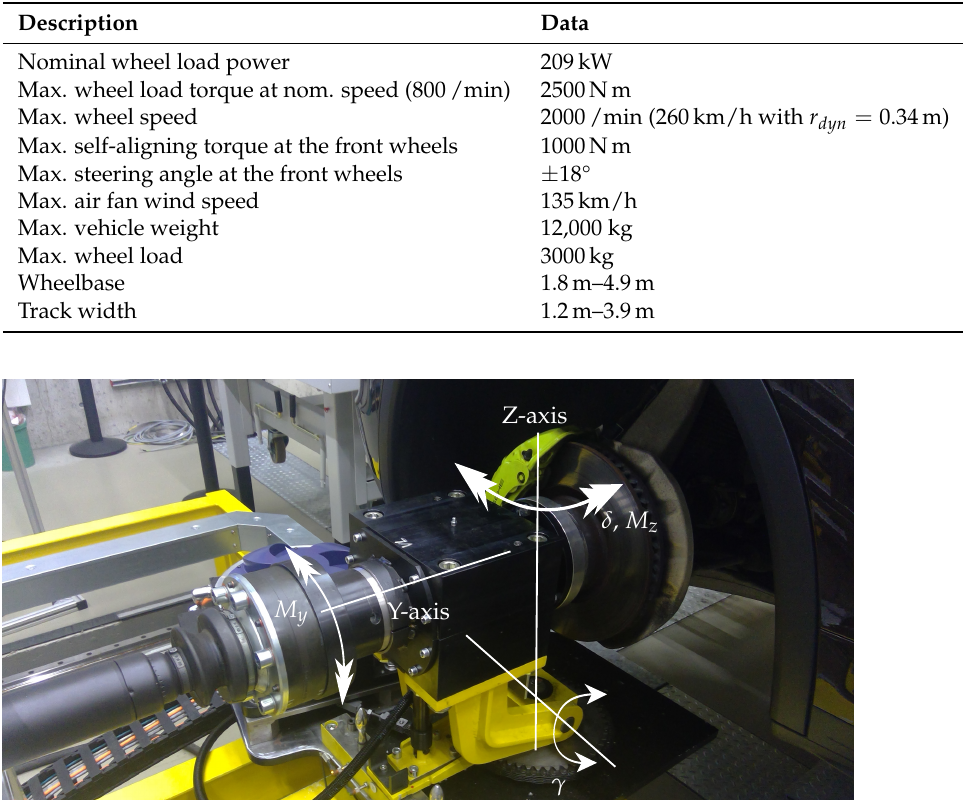
Table 3. Technical data of the test bench.